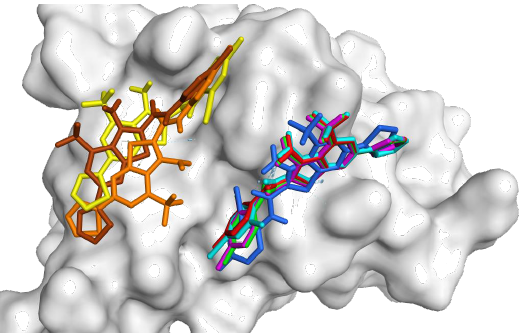
Figure 6. Docking poses from the -CN ( 2 (blue), 6 (yellow), 11 (orange), and 16 (brown)) and -CH 3 ( 1 (green), 10 (purple), and 15 (light blue)) substituted compounds compared to FDI-6 (red) in the FOXM1-DBD.